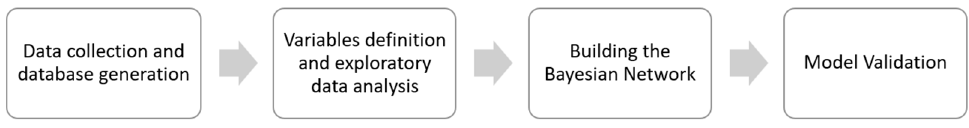
Figure 1. Methodology steps for the generation of the model.